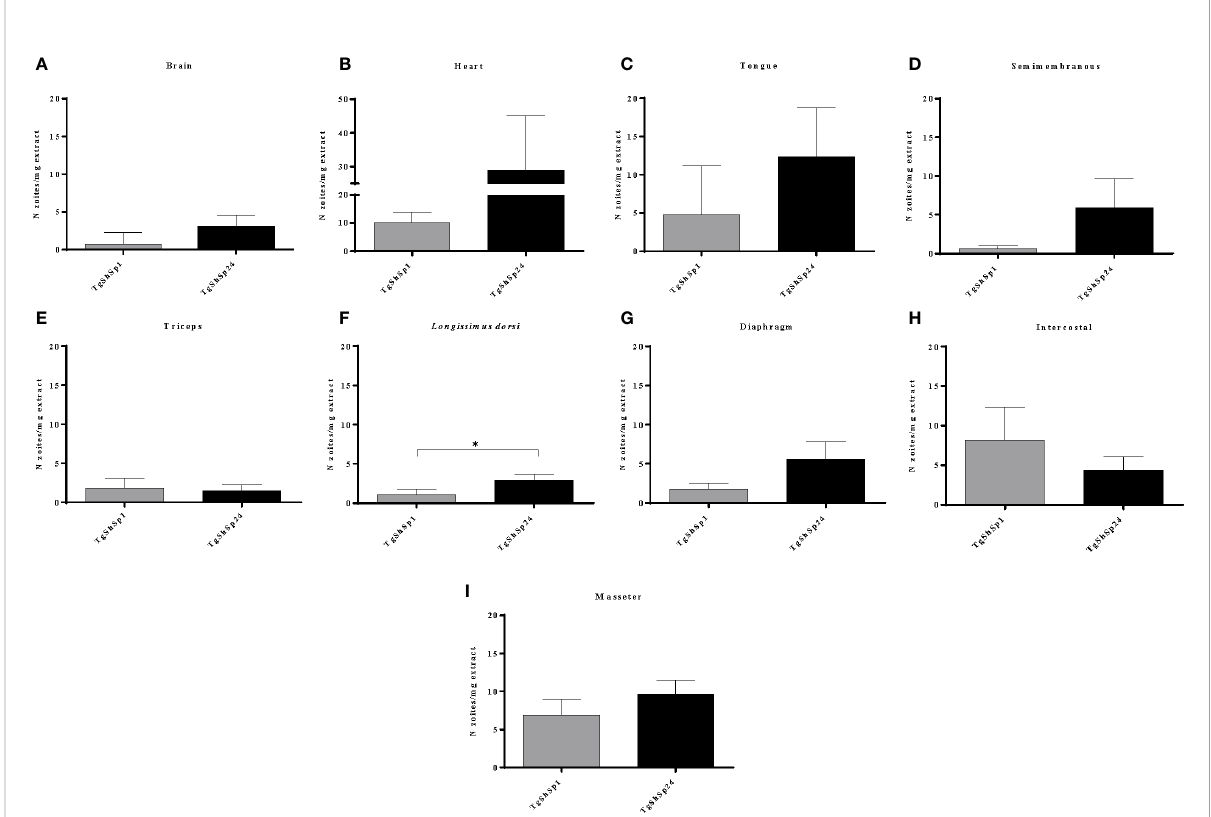
FIGURE 3 Toxoplasma gondii burdens quanti fi ed by 529 bp RE qPCR analysis performed on homogenates from pig tissues: brain (A) , heart (B) , tongue (C) , semimembranosus (D) , triceps (E) , longissimus dorsi (F) , diaphragm (G) , intercostal (H) and masseter (I) . Column-plot graphs represent the mean parasite burdens as the number of zoites per mg of tissue infected with TgShSp1 and TgShSp24 isolates. Error bars indicate the SEM. *Statistical differences between infected groups (p <